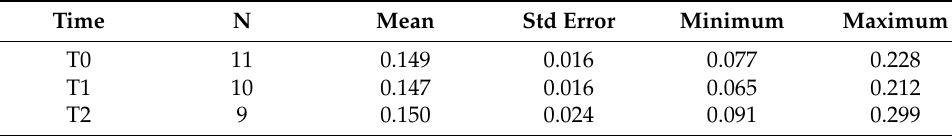
Table 4. Descriptive statistics of salivary